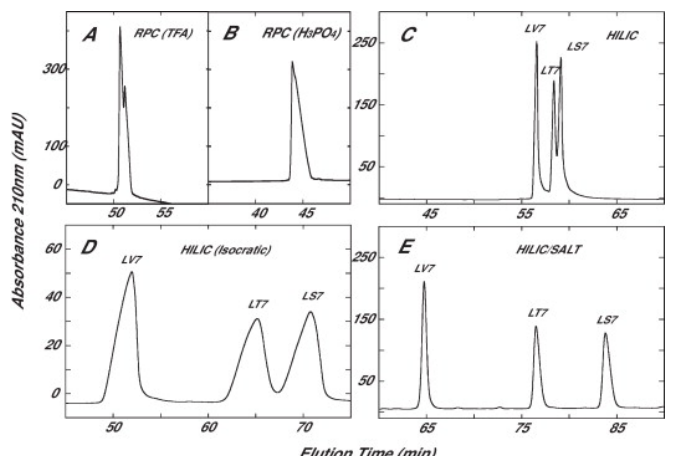
Figure 4. Separation of a mixture of LV7, LT7 and LS7 peptides by RP-LC with TFA (panel A ) or phosphoric acid (panel B ) as the ion-pairing reagent, HILIC (decreasing concentration of acetonitrile, panel C ), isocratic HILIC (isocratic concentration of acetonitrile, panel D ) and HILIC/SALT (isocratic concentration of acetonitrile and salt gradient, panel E ). Reproduced with permission from